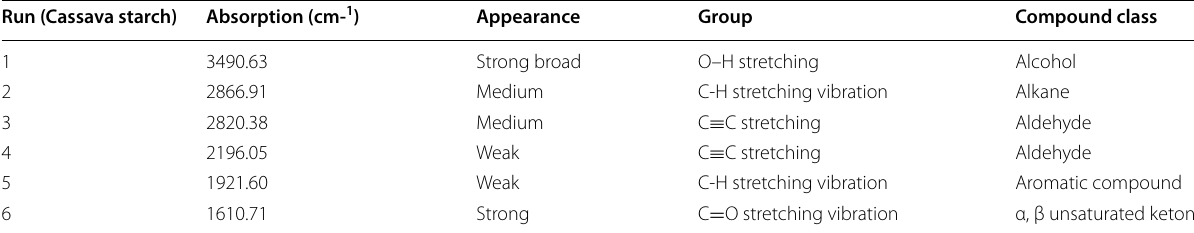
Table 3 FTIR analysis spectra for cassava starch (B2) microcapsules Run (Cassava